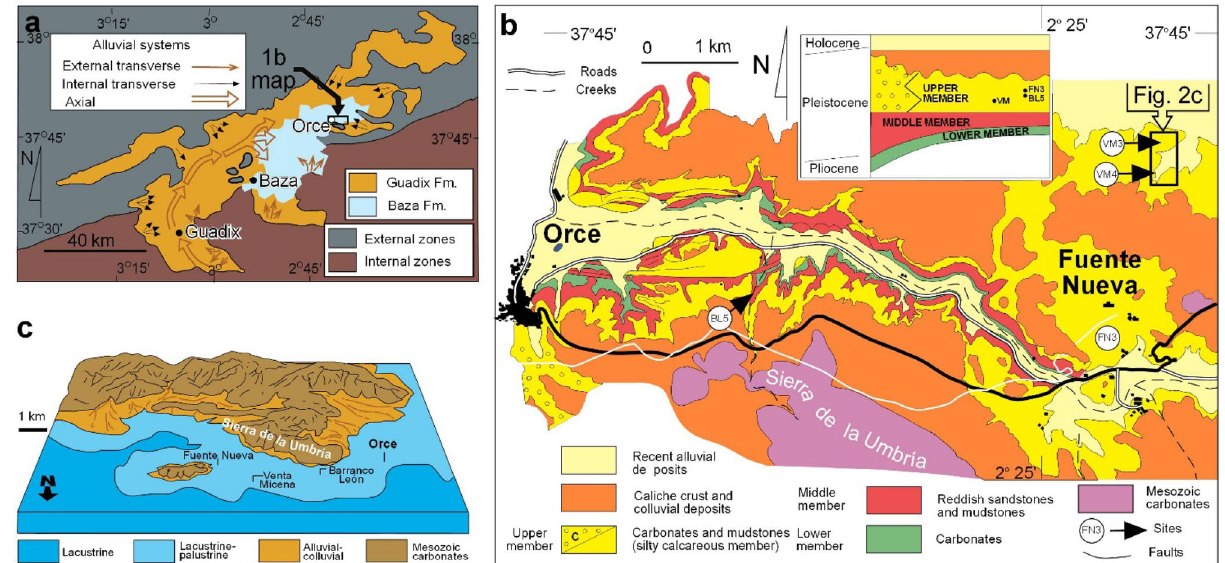
Figure 1. ( a ) Geological map of the Guadix-Baza basin and paleolake, with the area of the detailed map in b indicated. ( b ) Geological map 6 of the main sites in the Orce area (BL5: Barranco León 5, FN3: Fuente Nueva 3, VM3: Venta Micena 3). The rectangle to the upper left is the area represented in Fig. 2c. ( c ) Paleogeographical setting of the Venta Micena, Barranco León and Fuente Nueva sites. Maps created with Inkscape 1.0.1 (3bc2e813f5, 2020-09-07) software (https:// inksc ape. org/